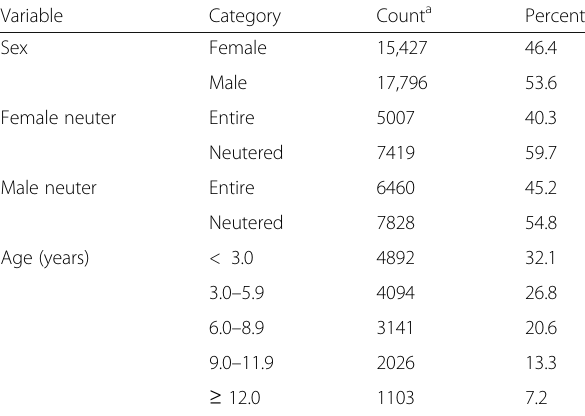
Table 1 Demography of Labrador retrievers under primary veterinary care at practices participating in the VetCompass ™ Programme in the UK from January 1st 2013 to December 31st